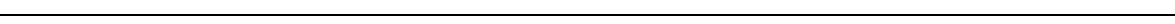
Fig. 2 Electrophysiology of α GckKO α -cells. a Examples of α -cells electrical activity in response to the indicated glucose concentration recorded from Ctrl (top line) and α GckKO islets (bottom line). Right panels: single action potentials recorded at 1G (black) or 6G (red) with expanded time scale. See also Supplementary Fig. 4. b Summary of Ctrl α -cell action potential peak voltage, anti-peak voltage, and fi ring frequency in response to 1G and 6G glucose. n = 4; * p < 0.05; Student ’ s t -test. c Same as b for α GckKO α -cells. n = 4. d Examples of K ATP current measured in α -cells of Ctrl (upper panel) and α GckKO (lower panel) islets. e Summary of K ATP conductance, expressed as delta between 1G and 6G glucose (normalized to cell size; pS/pF), measured at 1G and 6G. n = 6 per genotype. * p < 0.05; Student ’ s t -test. Data are represented as mean ± s.d. f Voltage-dependent exocytosis in α -cells of Ctrl (middle traces) and α GckKO (bottom traces) islets. Cell exocytosis was monitored as increase in cell membrane capacitance ( Δ Cm) induced by membrane depolarizations. The responses were evoked by depolarizations from − 70 mV to the indicated voltages (top schematic traces: red − 30 mV, blue 0 mV + 30 mV). g Relationship of the α -cell exocytosis ( Δ Cm) with depolarizations from − 70 mV to different voltages ( V ). Open circles Ctrl ( n = 10), black fi lled circles α GckKO ( n = 6). Data are represented as mean ±